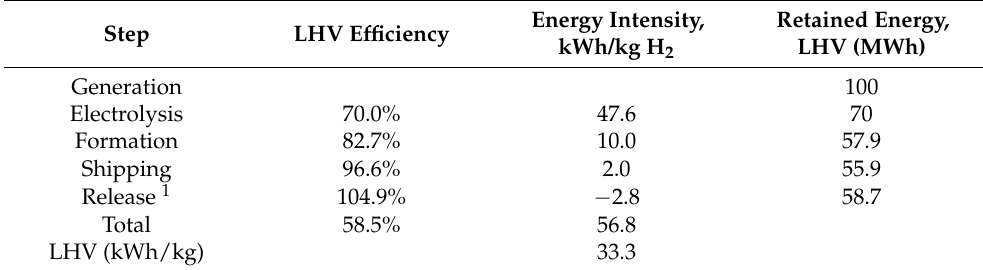
Table 4. Summary of energy efficiency for the various stages in a liquid hydrogen supply